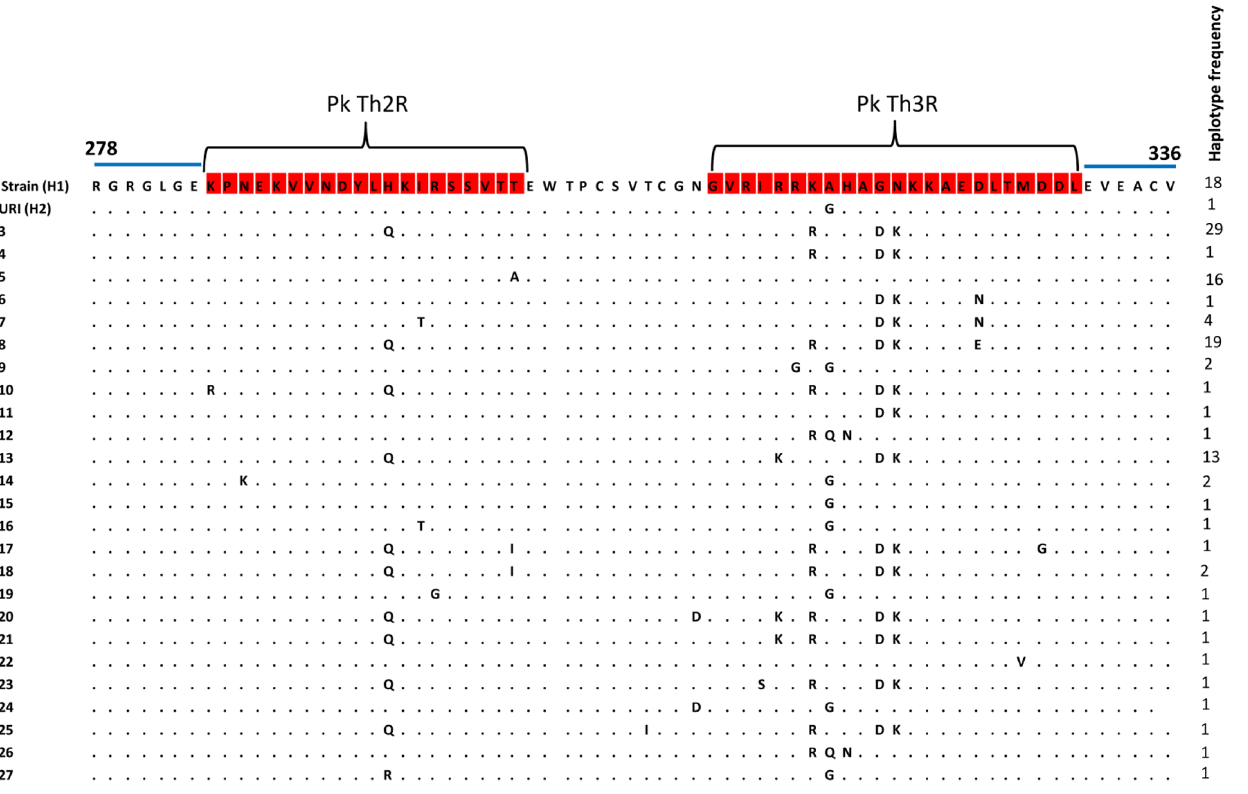
Fig 5. Sequence diversity in the C-terminal nonrepeat region of PkCSP. Sequence alignment showing polymorphism in the nonrepeat C-terminal Th2R/ Th3R epitope regions. The highly conserved sequences flanking the Th2R/Th3R domains are indicated by the blue line over the alignment.